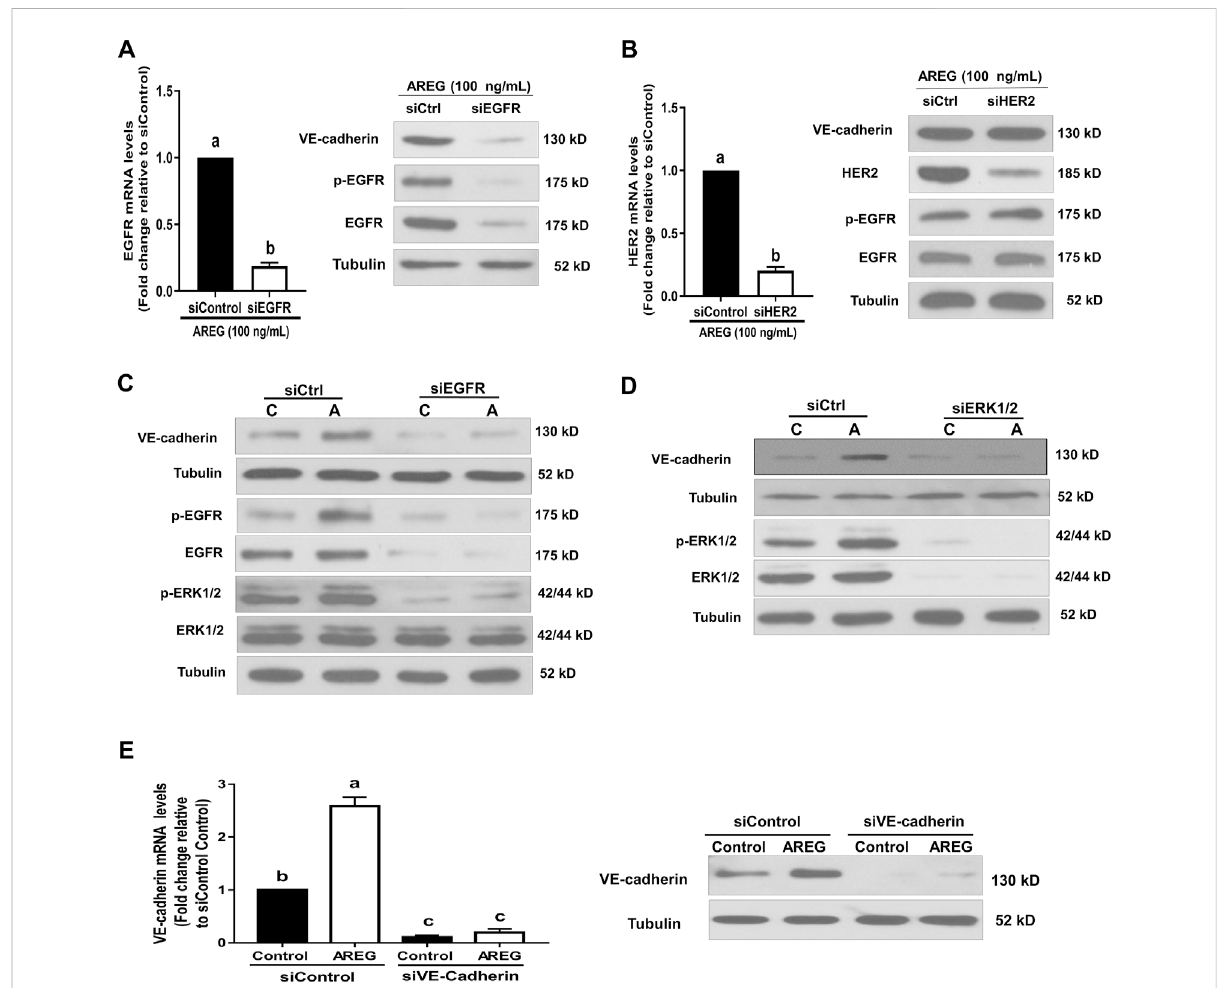
FIGURE 6 Effects of targeted depletion of EGFR, HER2, ERK1/2 and VE-cadherin on the AREG-induced upregulation of VE-cadherin. (A,B) SVOG cells were transfected with 25 nM siControl, siEGFR (A) or siHER2 (B) for 24 h in the presence of AREG (100 ng/ml), the expression levels of EGFR or HER2 were examined by RT-qPCR and western blotting, respectively. (C,D) Cells were transfected with 25 nM siControl, siEGFR (C) or siERK1/2 (D) for 24 h and then treatedforanadditional15 min(fordetectingphosphorylatedEGFRandERK1/2)or24 h(fordetectingVE-cadherin)withorwithoutAREG(100 ng/ml). The phosphorylation levels of EGFR, ERK1/2 or VE-cadherin were examined by western blotting. (E) SVOG cells were transfected with 25 nM siControl or siVE-cadherinfor24 handthentreatedforfurther24 hwithorwithoutAREG(100 ng/ml).TheexpressionlevelsofVE-cadherinwereexaminedbyRT-qPCR and western blotting, respectively. Values labeled with different letters are signi fi cantly different ( p < 0.05) n =